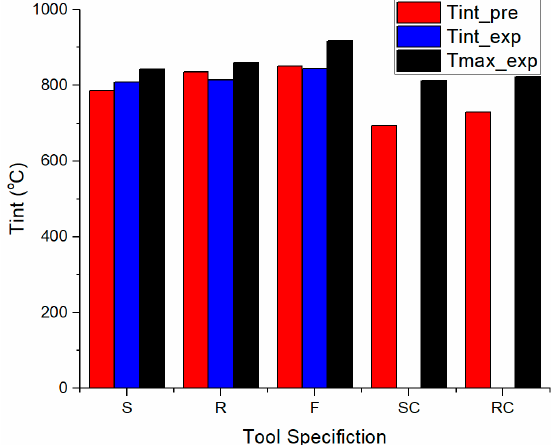
Figure 6. Temperature predictions in orthogonal machining of AISI 4340 steel. Red color, blue color, and black color represent predicted average temperature, experimental average temperature, and experimental maximum temperature at SSZ respectively.